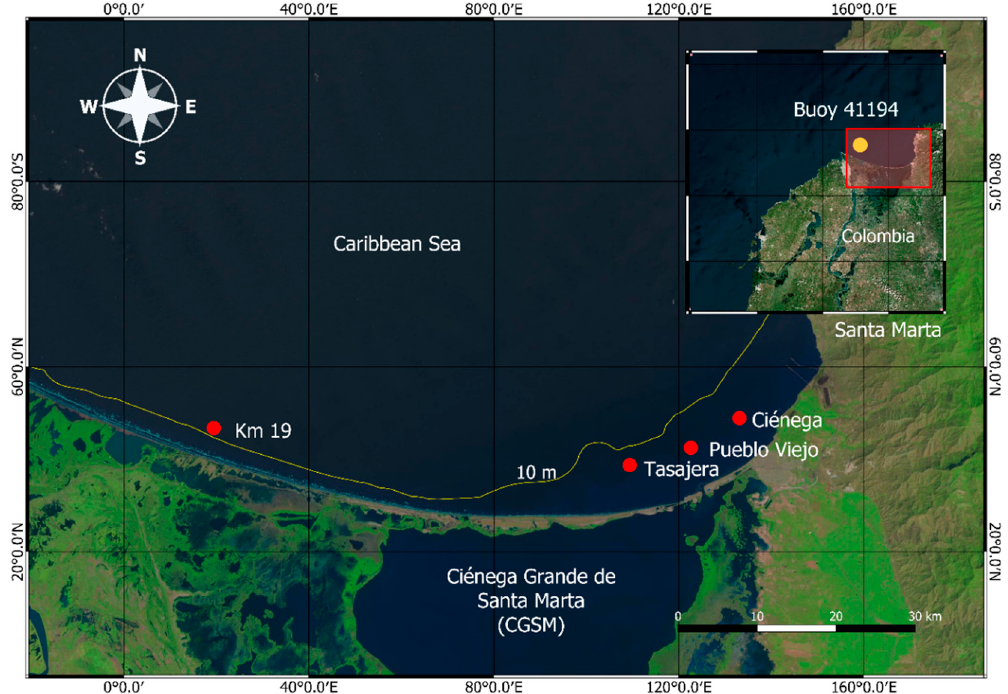
Figure 5. Location of the virtual buoys (red dots). Note the variations in the width of the inner shelf and the orientation from west to east indicated by the 10 m isobath. The domain of the Simulating Waves Nearshore (SWAN) model is shown in the upper panel.